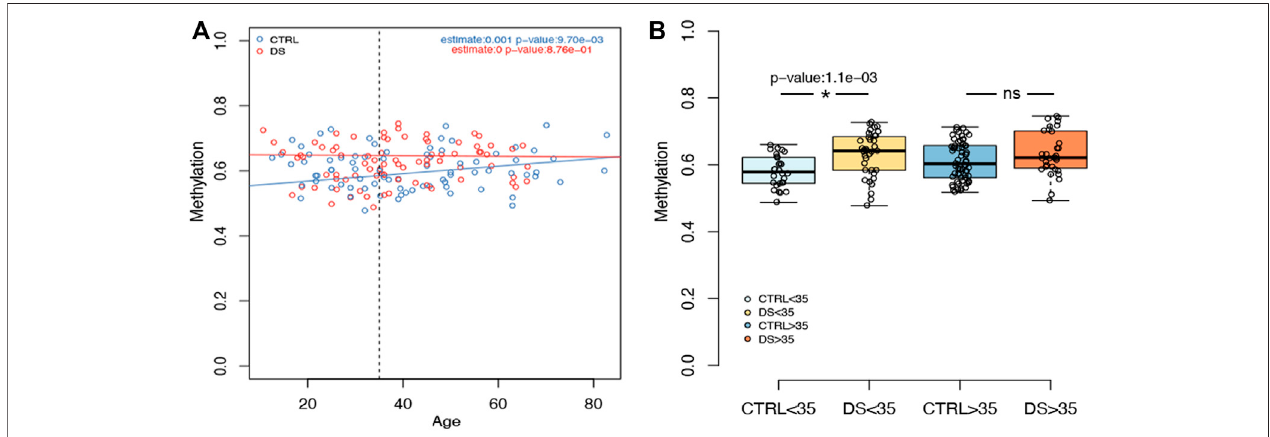
FIGURE 3 | Examples of rDNA methylation values according to age. (A) For CpG 8 within RiboProm_2 amplicon, the boxplot reports the association between DNAm and age in persons with DS and controls. Estimate and p -values were calculated, respectively, by a linear model and by ANOVA correcting for age, sex, and batch. (B) For the same CpG site, the boxplots highlight DNAm differences between DS and control groups strati fi ed by age (threshold = 35 y.o). P -values were calculated using an ANOVA test after correcting for age, batch, and sex.